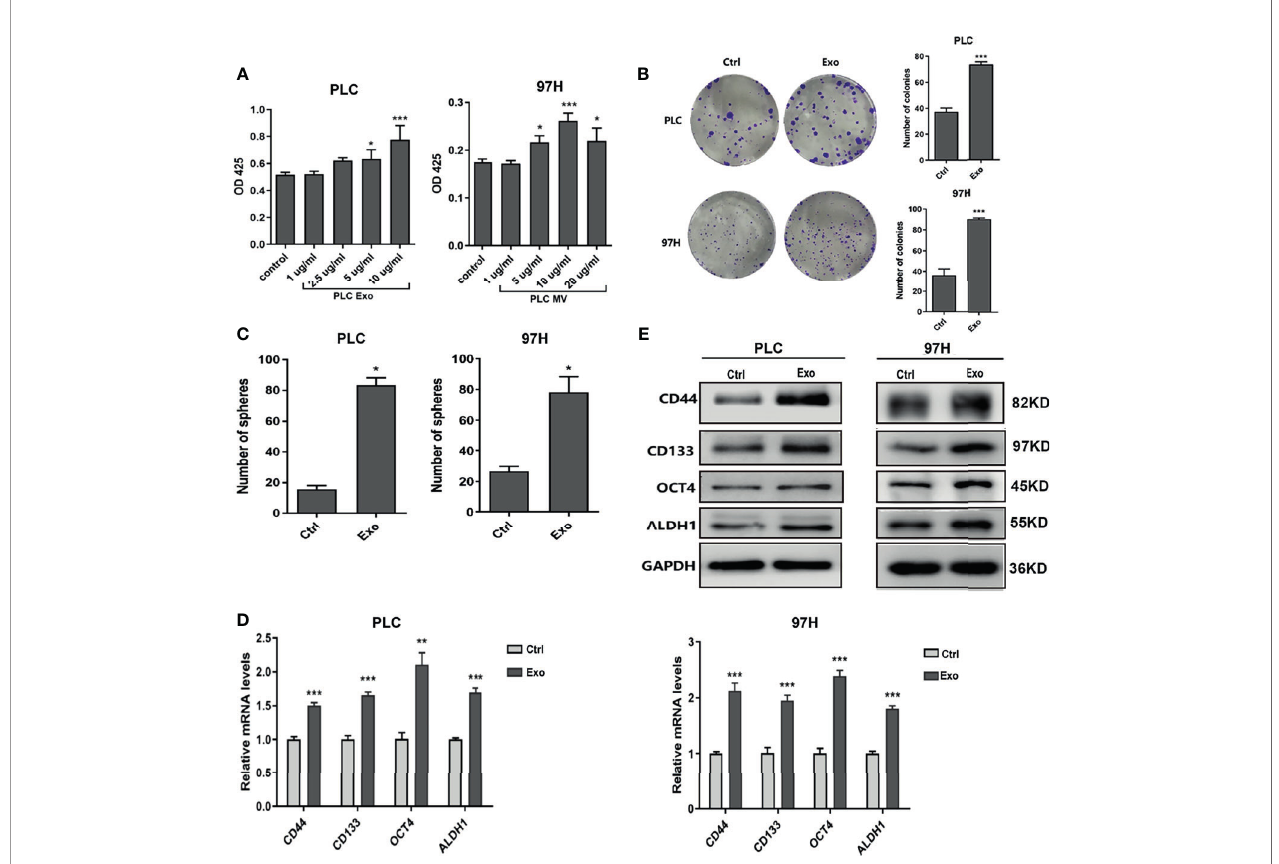
FIGURE 2 | Effect of exosomes on HCC cell growth. (A) Proliferation of PLC/PRF/5 and MHCC-97H in the presence of various concentrations of exosomes isolated from culture medium of the same cell line as measured by CCK8 assay. (B) Colony formation assay and (C) count of sphere formed in PLC/PRF/5 and MHCC-97H with and without exosomes (10 m g/ml) isolated from the culture medium of the same cell line. (D) Quantitative PCR analysis of the mRNA levels, and (E) Western blot analysis of the protein levels of stem cell marker genes in PLC/PRF/5 and MHCC-97H cells cultured with and without exosomes (10 m g/ml) isolated from the culture medium of the same cell line. The data are presented as an average of three biological replicates. * p < 0.05, ** p < 0.01, *** p <